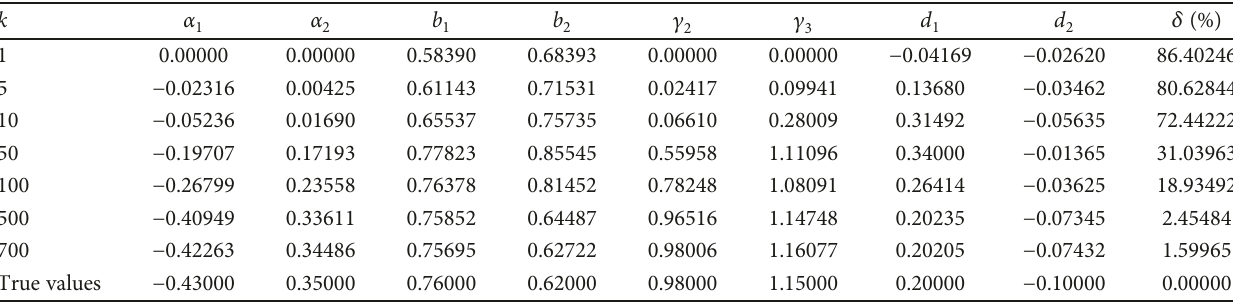
Table 1: The GI estimates and errors ( σ 2 = 0 10 2 ).